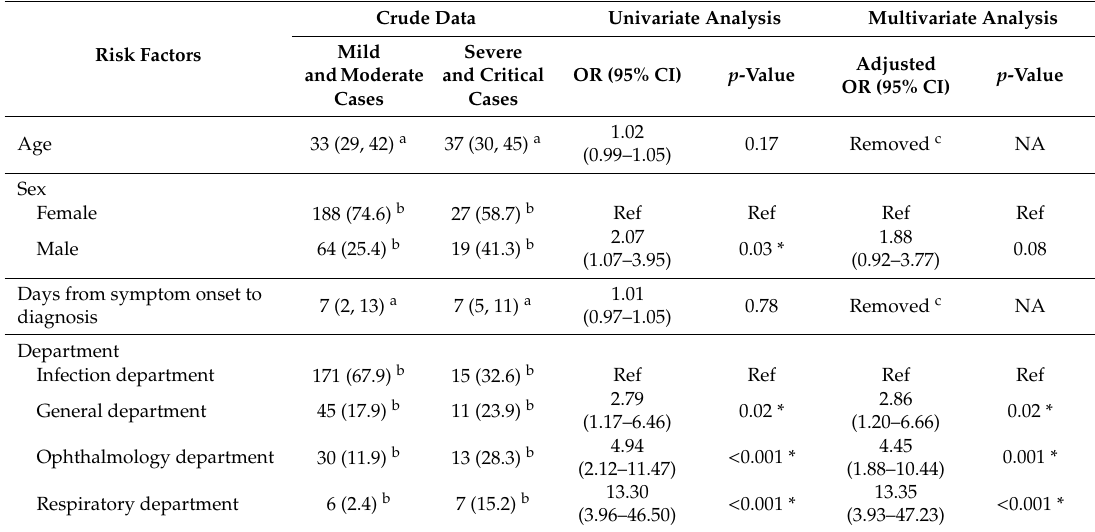
Table 4. Risk factors for being severe or critical cases of COVID-19 by logistic